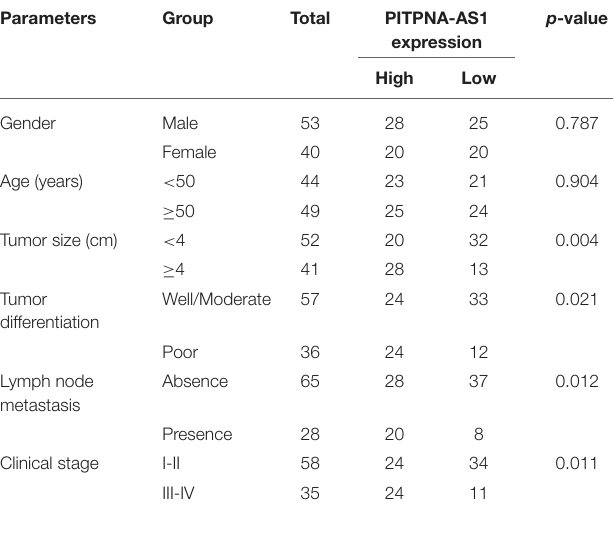
TABLE 2 | Relationship between PITPNA-AS1 expression and clinicopathological characteristics. Parameters